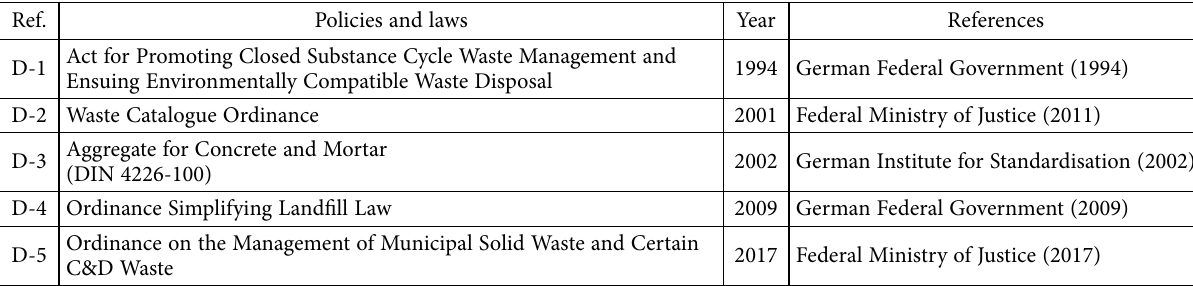
Table 5. Existing policies and laws on C&D waste management in Germany Ref.